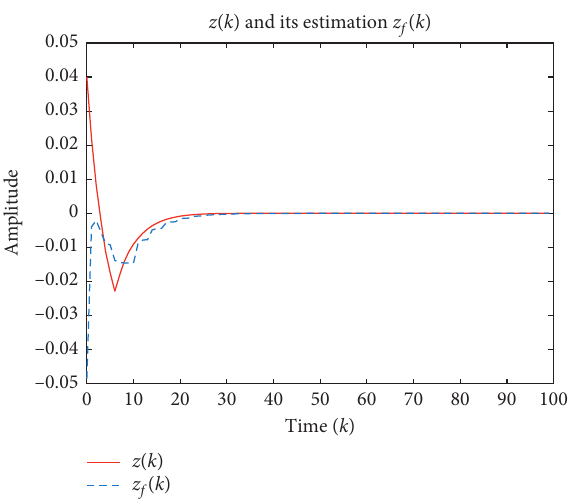
Figure 8: The response of z ( k ) and z